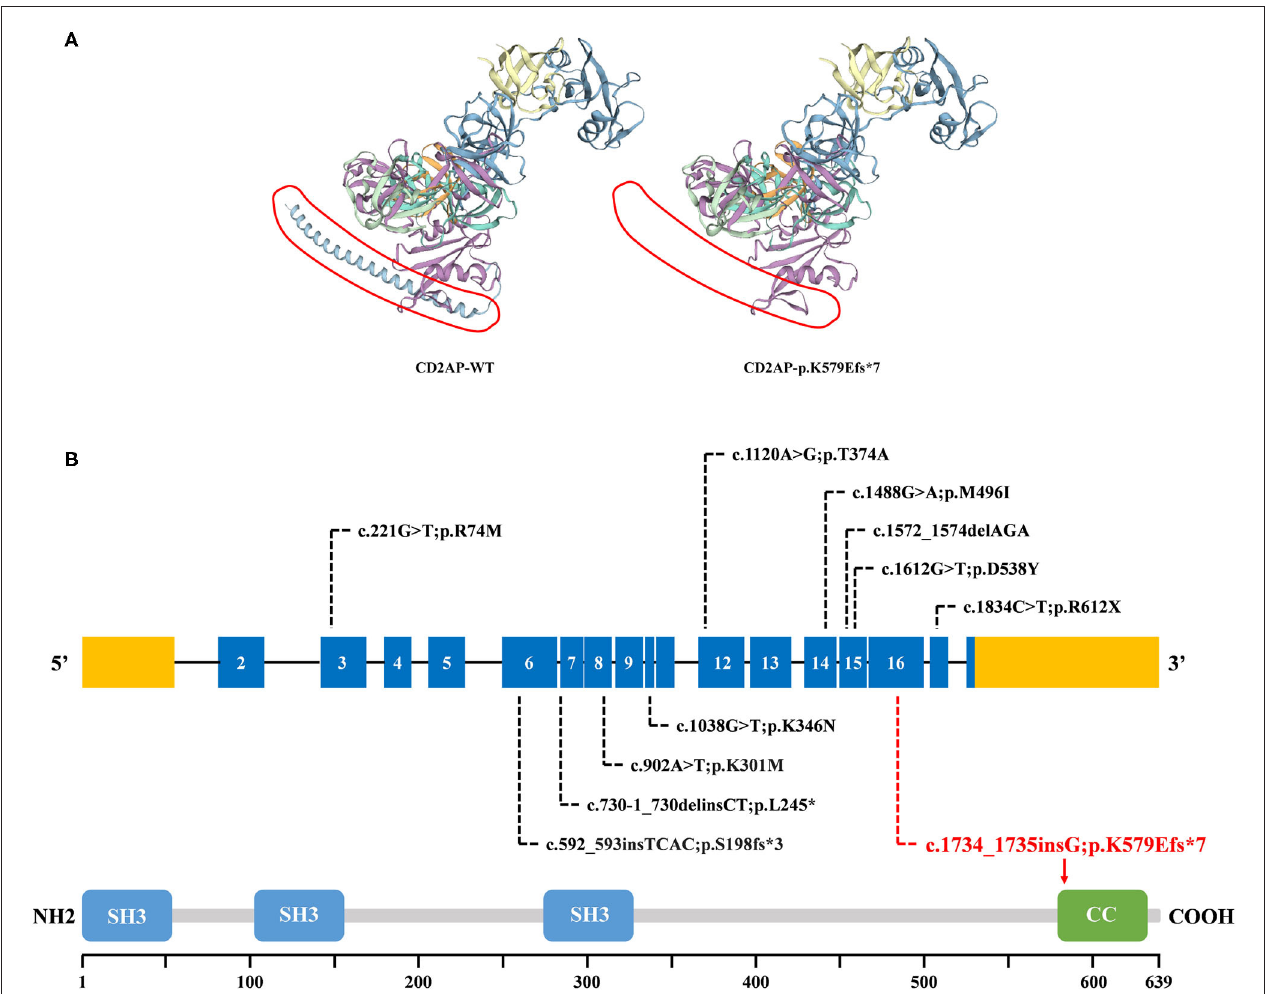
FIGURE 2 | The bioinformatics analysis of mutations. (A) Structure prediction of the mutant protein. The wild type CD2AP (CD2AP-WT) protein structure and the p.K579Efs*7 mutant CD2AP (CD2AP-p.K579Efs*7) protein structure were predicted by SWISS-MODEL online software. (B) Overview of all known and novel CD2AP mutations. The CD2AP gene is shown, with all known CD2AP mutations (black letters) and novel mutation (red letters). Blue rectangles indicate exons. Introns are not shown to scale. The CD2AP protein structure is shown. CC, coiled-coil domain; SH3, Src homology 3